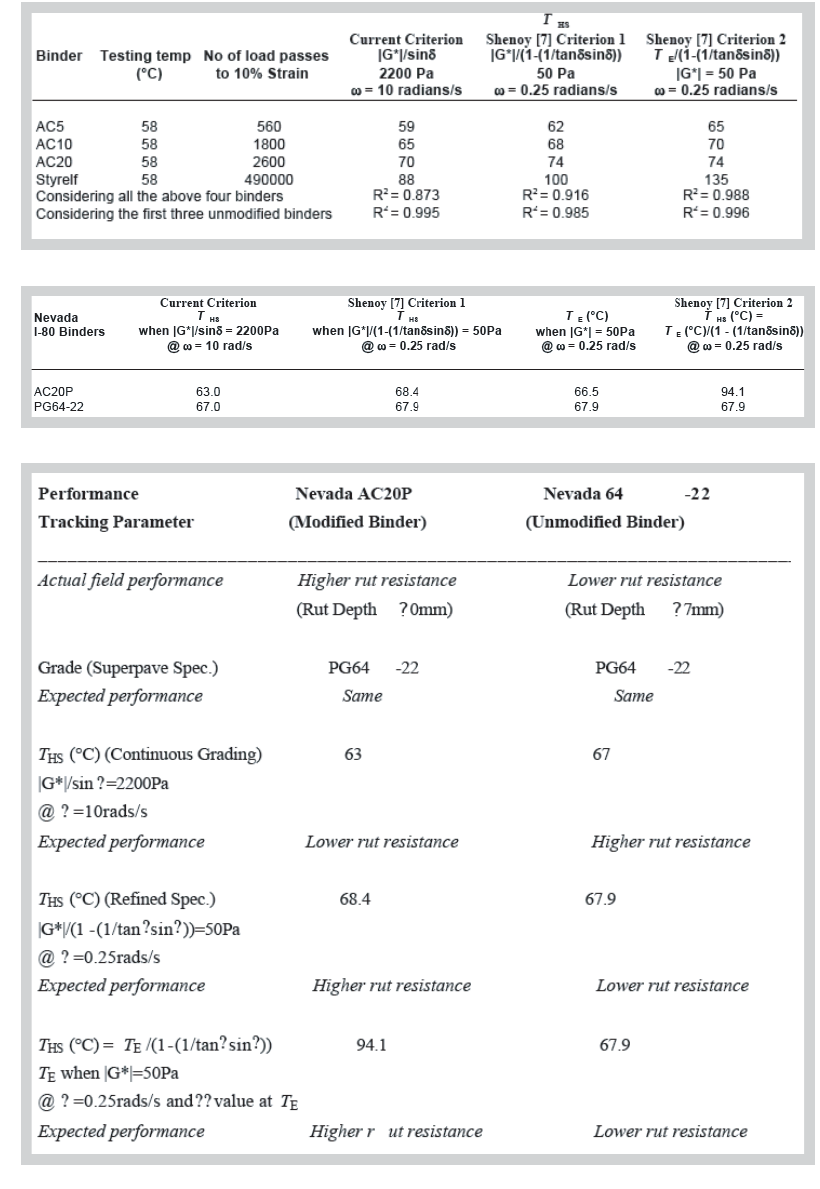
Table 2 (above): Comparison of the high specification temperature T HS for